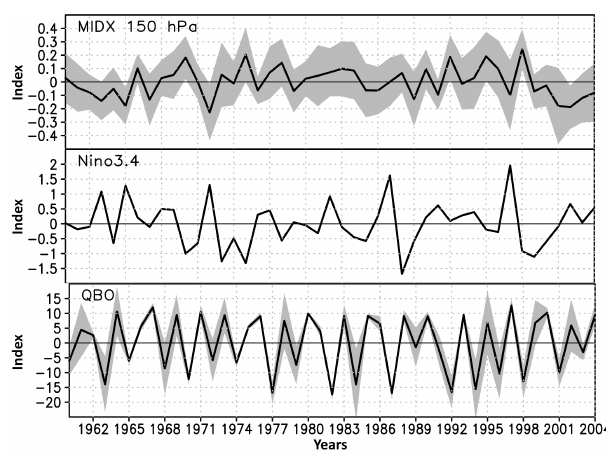
Figure 1. Time series of JA averaged basis functions for the pe- riod 1960–2004. Top: index for the monsoon circulation (MIDX) at 150hPa; middle: Niño3.4 index derived from the HadISST1 data set; bottom: zonal mean zonal wind at 50hPa near the Equator used as a QBO index. The black lines indicate the multi-model mean of the individual time series used for each CCM. Grey shadings indi- cate 1 standard deviation of the multi-model mean